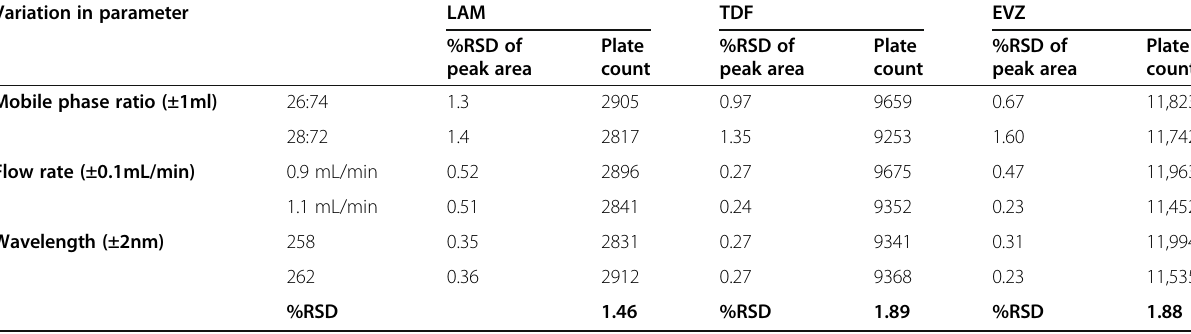
Table 6 Results of robustness of standard solution Variation in